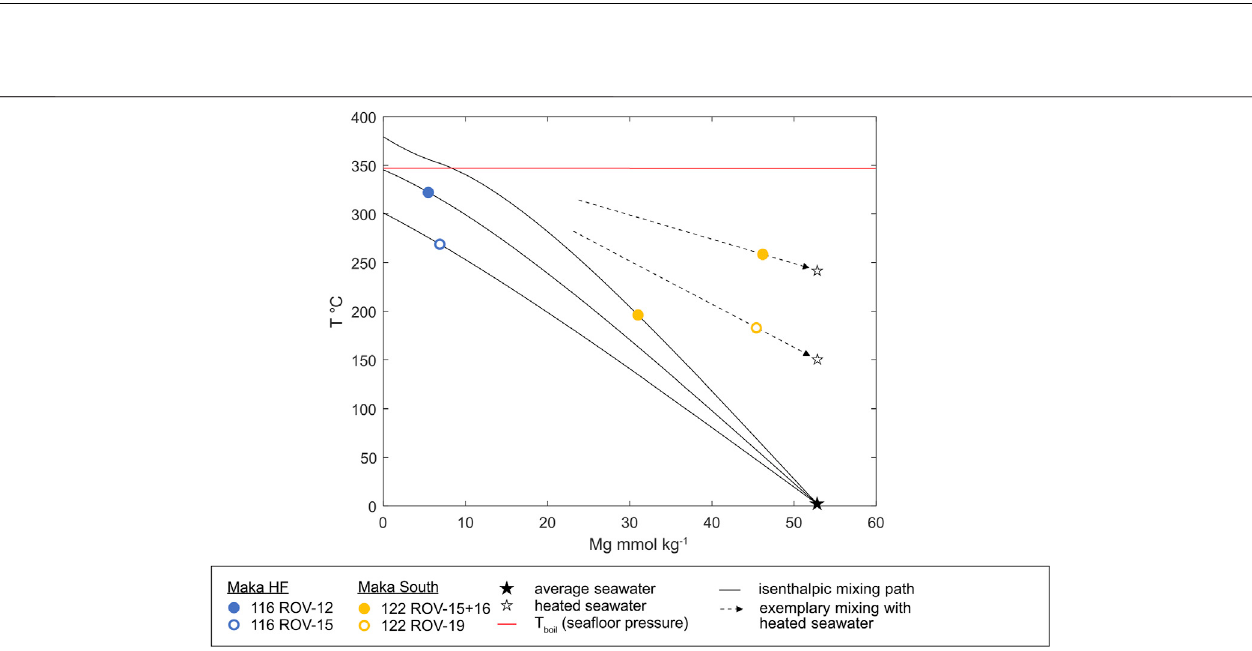
FIGURE 8| Temperature vs. Mg concentrations of the Maka vent fl uids and predicted isenthalpic-isobaric mixing paths between hydrothermal end-members and cold seawater (black star). The dashed arrows indicate the direction of mixing paths with heated and compositionally unmodi fi ed seawater to explain the high temperatures in combination with the high Mg concentrations at Maka South.